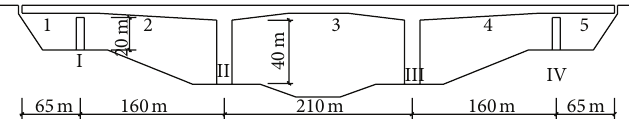
Figure 10: Schematic diagram of the long-span bridge.